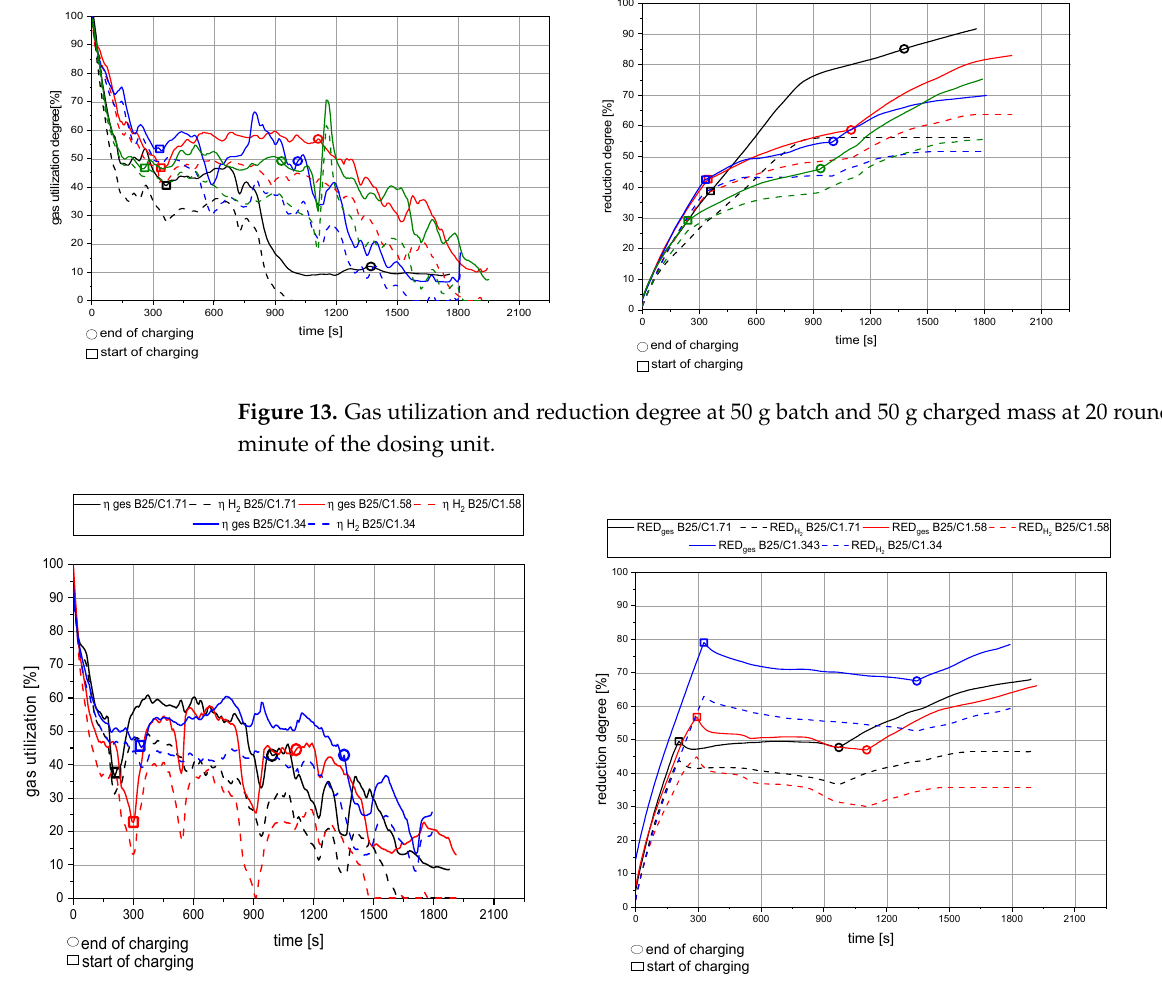
Figure 14. Gas utilization and reduction degree at 25 g batch and 75 g charged mass at 20 rounds per minute of the dosing unit.